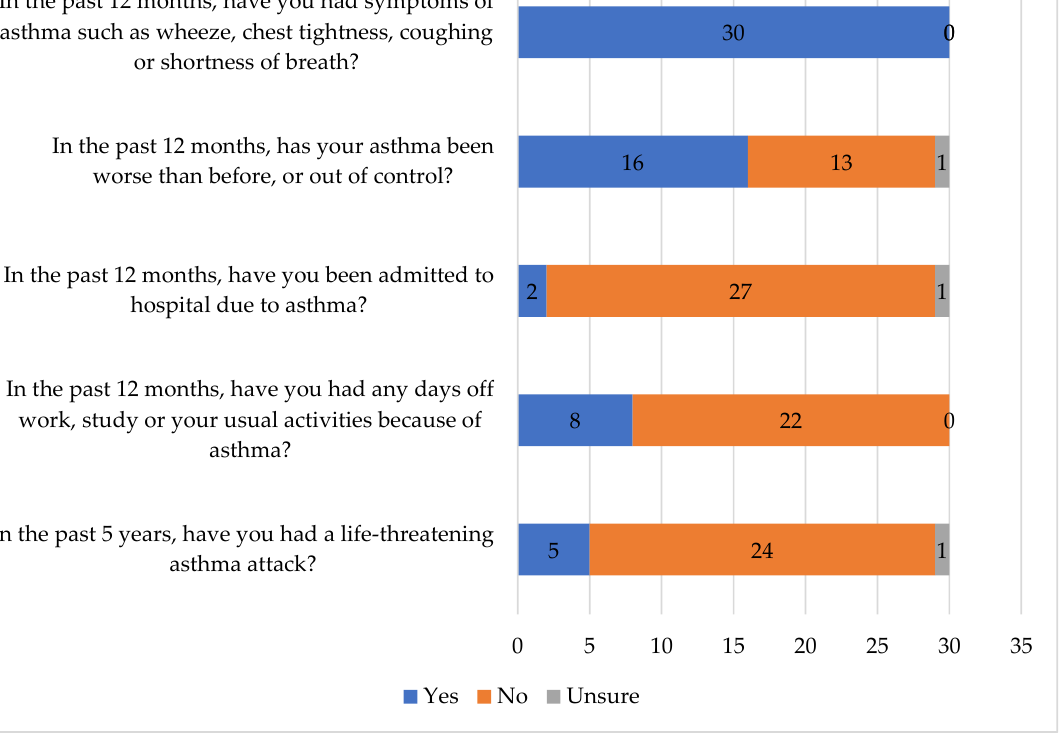
Table 3. Comparison of validated test scores at baseline and follow-up. p -values were obtained from the paired t -test to compare the change in means from baseline to follow-up.